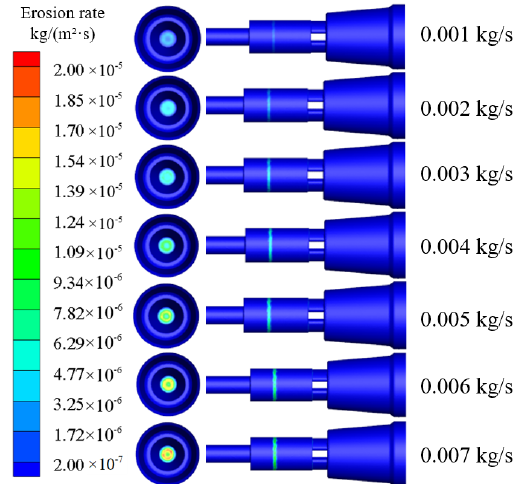
Figure 8. Erosion area changes with mass